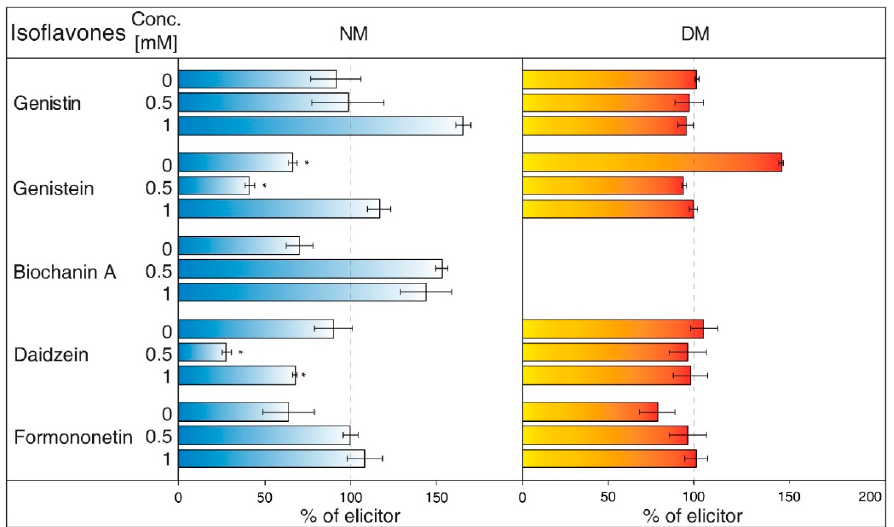
Figure 7. Effects of probenecid on isoflavone content in nutrient medium (NM) and dry matter (DM) of Genista tinctoria cell culture. Zero concentration of inhibitor represents water control. All bar values were recalculated to a relative 100% isoflavone content in samples with NH 4 VO 3 (1 μ M) after 24 h. Data are mean of three repeats ± SE; (*) represent significant difference ( p < 0.05) between elicited and inhibited or water control samples within Tukey’s test.